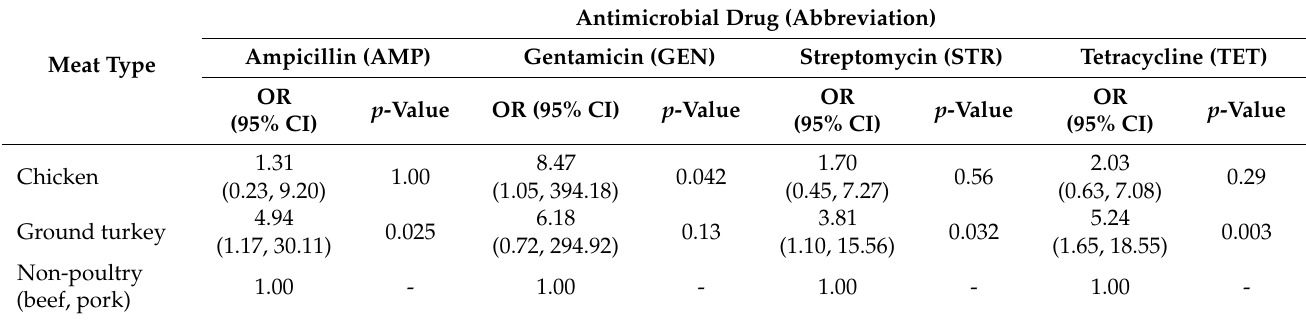
Table 3. Association between retail meat type and phenotypic antimicrobial resistance.